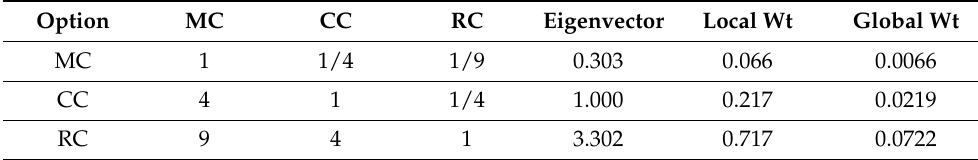
Table A18. Comparison of alternatives matrix for subcriterion EN2.